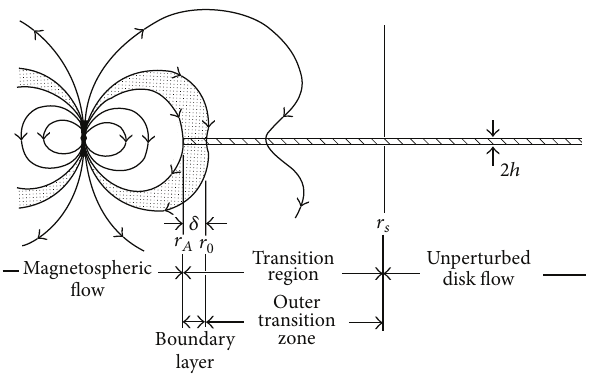
Figure 1: Schematic representation of the transition zone [41], which consists of an outer transition zone and a boundary